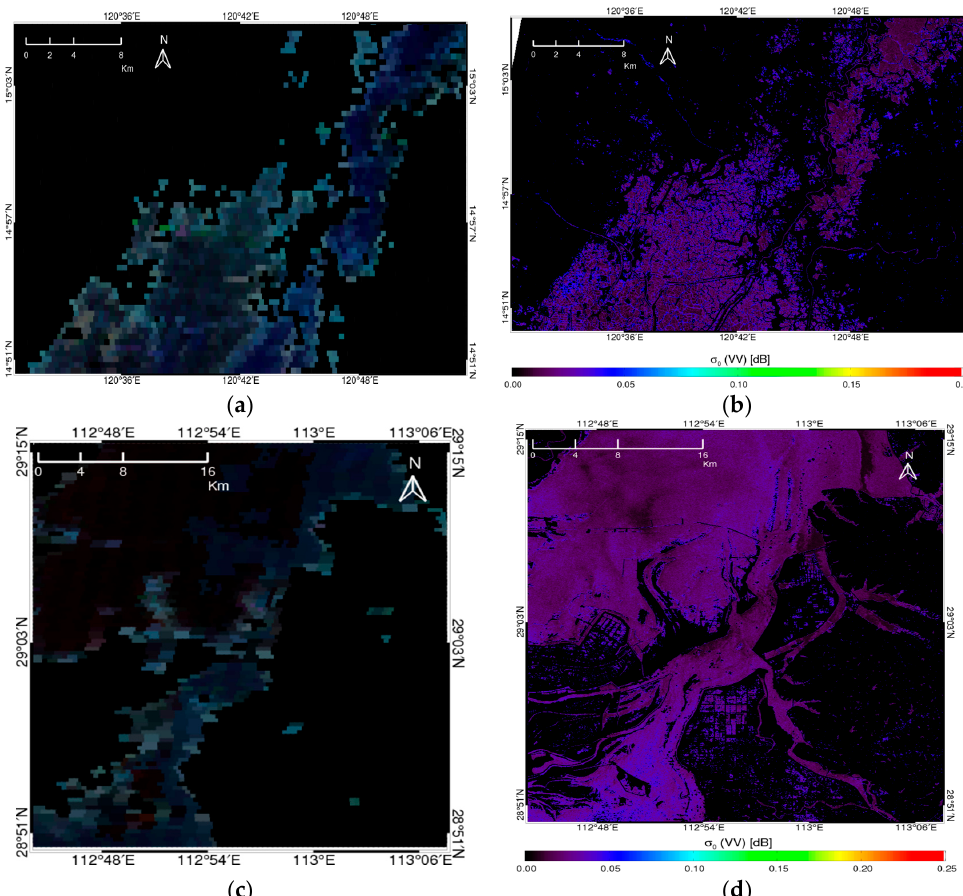
Figure 9. Flood area estimations around the Pampanga River using ( a ) RGB 6-5-2 imagery and ( b ) SENTINEL-1A data. Flood area estimations around the Poyang and Dongting Lakes using ( c ) RGB 6-5-2 imagery and ( d ) SENTINEL-1A data.